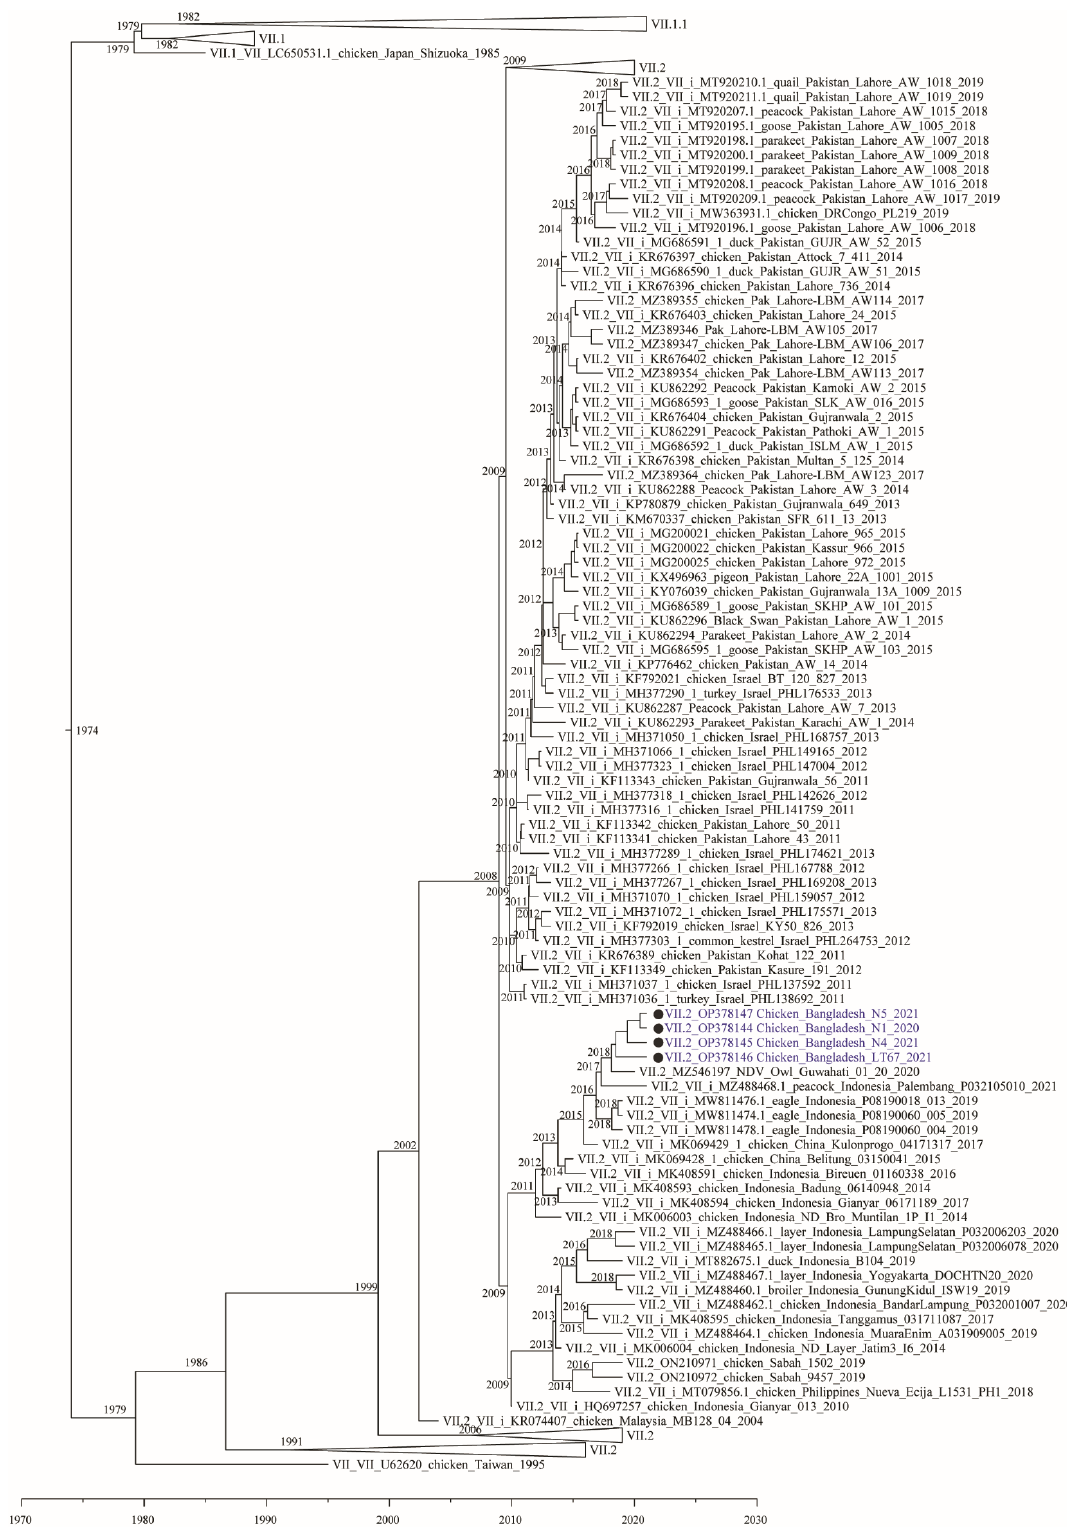
Figure 2. Maximum Clade Credibility (MCC) tree from Bayesian analysis utilizing a sub-set of all full fusion gene sequences ( n = 1013) of genotypes VII. The analysis was conducted by the Bayesian Markov Chain Monte Carlo (BMCMC) method implemented in BEAST v1.10.4. The four Bangladeshi isolates are highlighted with filled circle ( •